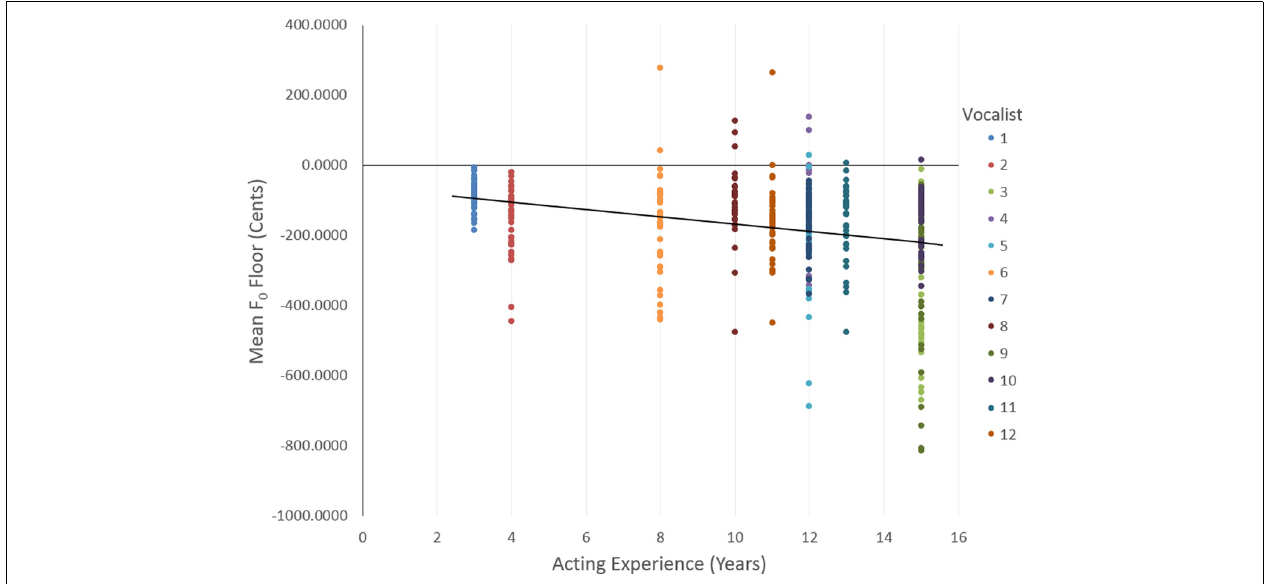
FIGURE 1 |Vocalists’ years of acting experience and F 0 floor of their first note for all trials. Solid black line indicates a line of best fit, with a linear regression solution: F 0 floor = − 62.66 − 10.37 × Acting